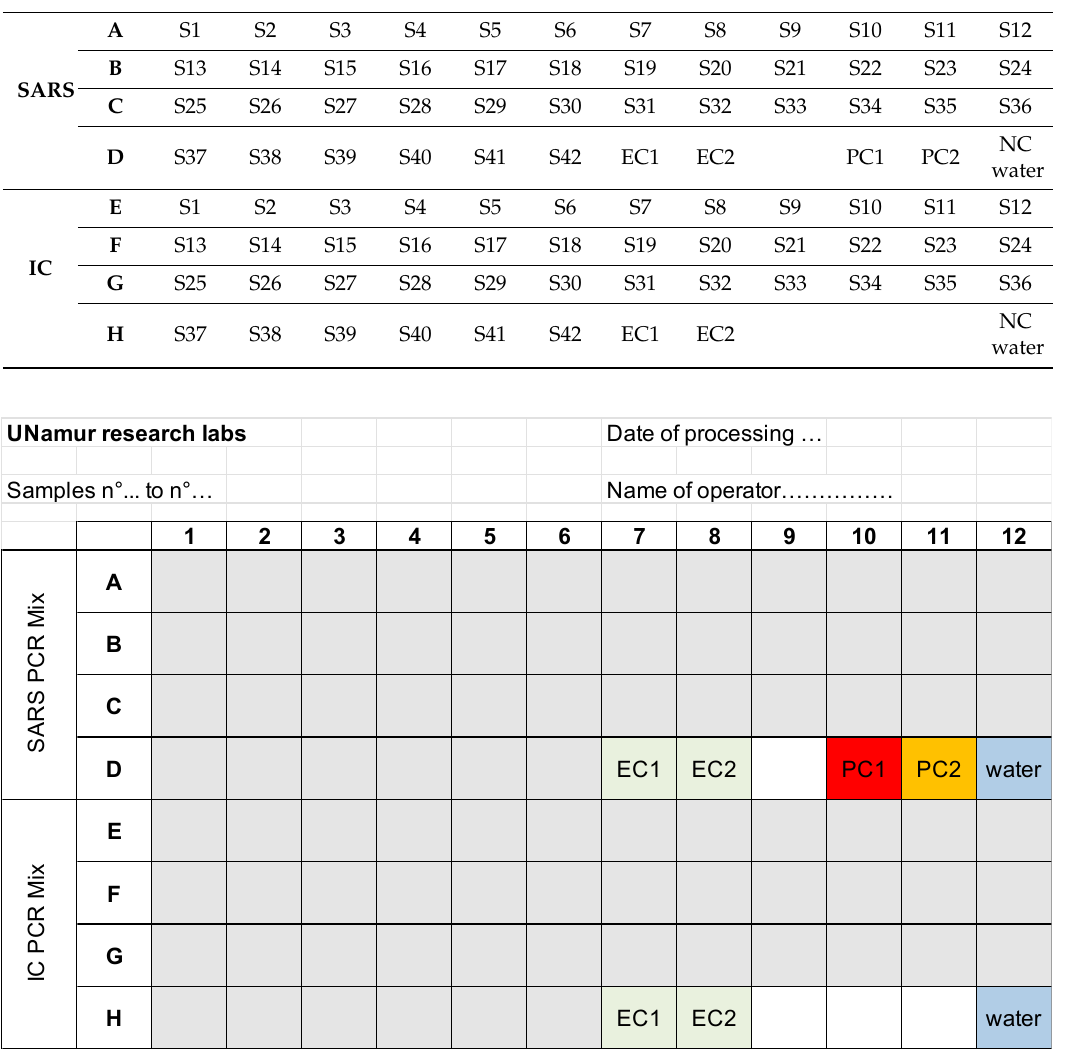
Figure 3. PCR loading form.